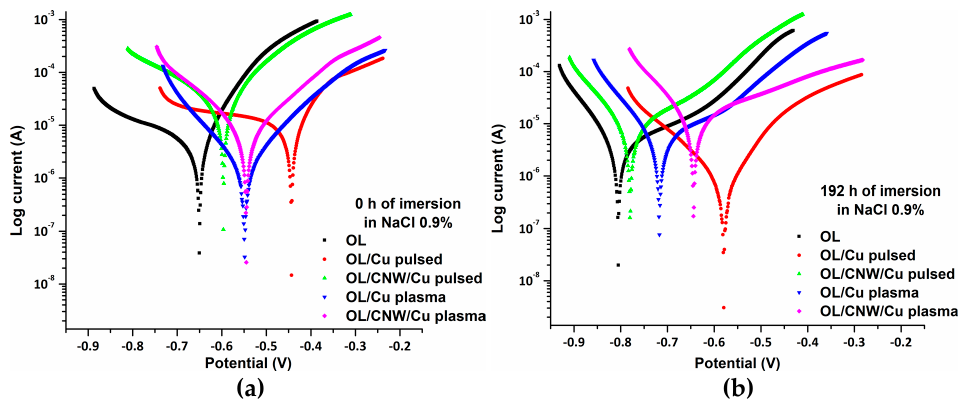
Figure 11. Tafel slopes after 0 h of immersion ( a ), and 192 h of immersion ( b ).